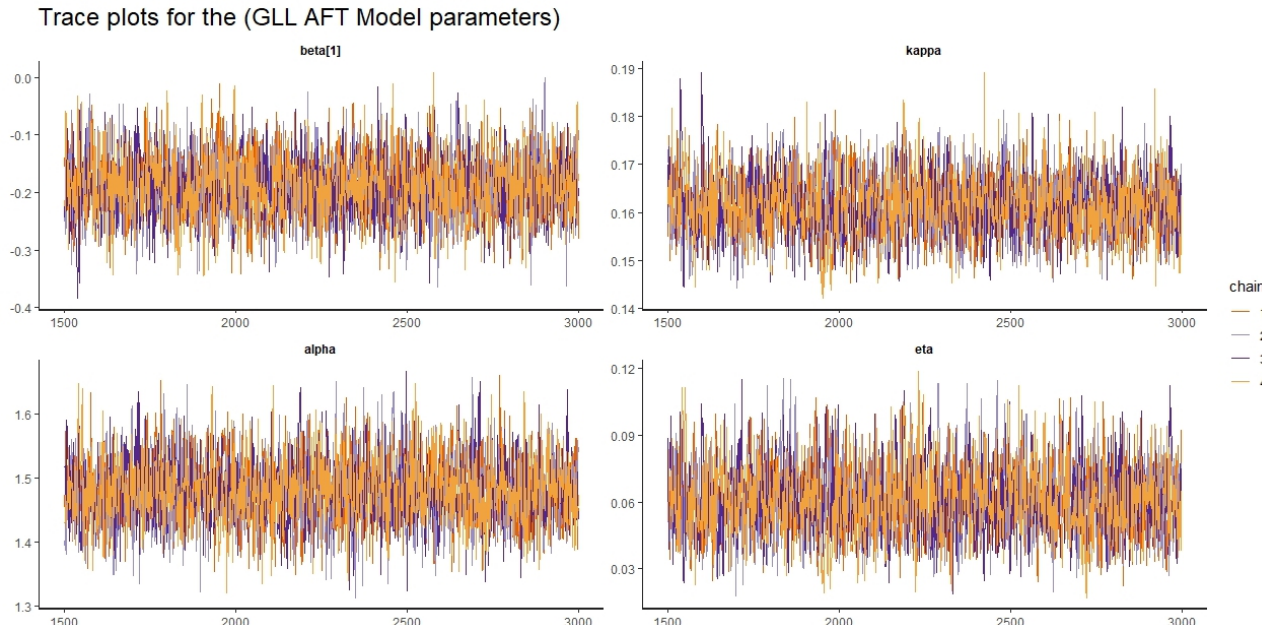
Figure 12. Trace plots for the GLL − AO model parameters.